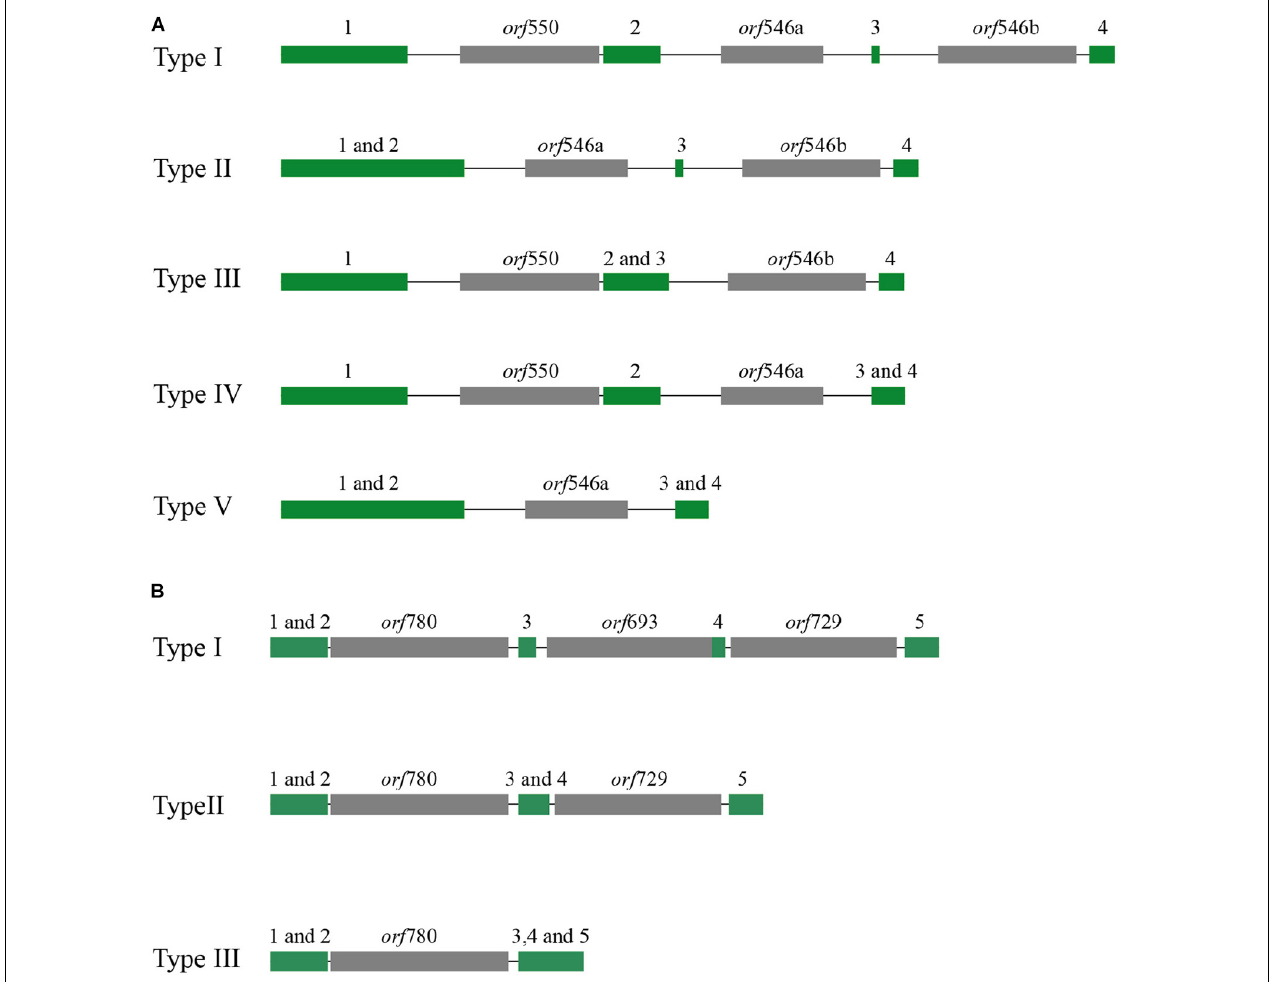
FIGURE 3 | Different types of distributions of group II introns: (A) rnl gene and (B) cox 1 gene. The exon of the rnl gene was composed of four coding regions (green block), and cox 1 was composed of five regions (numbers over the green block); the intronic open reading frame (ORF) was colored